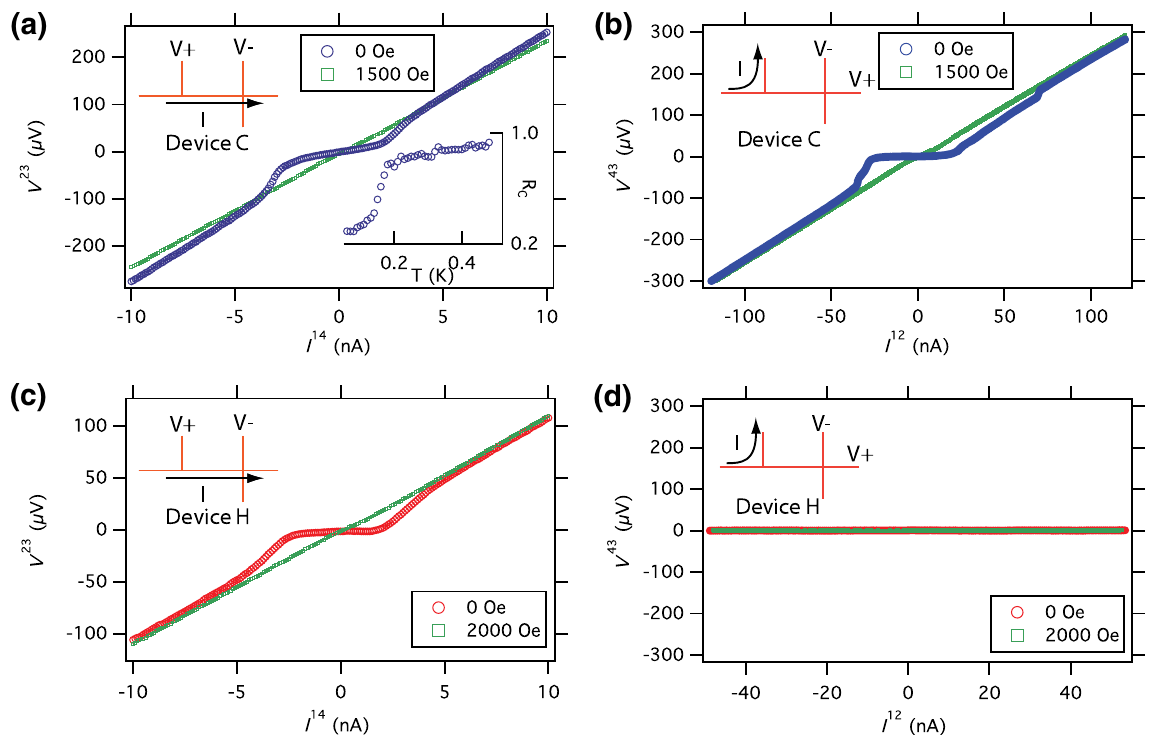
FIG. 3. Interaction between Cooper pairs and nonlocal transport. (a) Longitudinal I - V curves for device C at T ¼ 65 mK , below the superconducting critical temperature. The lower-resistance region of the H ¼ 0 curve is associated with the formation of Cooper pairs. Normal-state conduction is restored with application of an external magnetic field (green curve). The inset shows the temperature dependence of longitudinal resistance, indicating that the critical temperature is around 200 mK. The y -axis unit is h=e 2 . (b) Nonlocal of device C under conditions where Cooper pairs form (blue curve). The Cooper pairs block spin transport without resistance R 12 ; 43 current flow, which is required for manifestation of nonlocal resistance. Application of an external magnetic field restores the linear nonlocal response (green curve). (c) Longitudinal I - V curves for device H ð T ¼ 50 mK Þ in the superconducting regime ( H ¼ 0 ) and of device H under conditions where Cooper pairs form ( T ¼ 50 mK ). The normal state ( H ¼ 2000 Oe ). (d) Nonlocal resistance R 12 ; 43 C nonlocal signal is vanishing both above and below T c